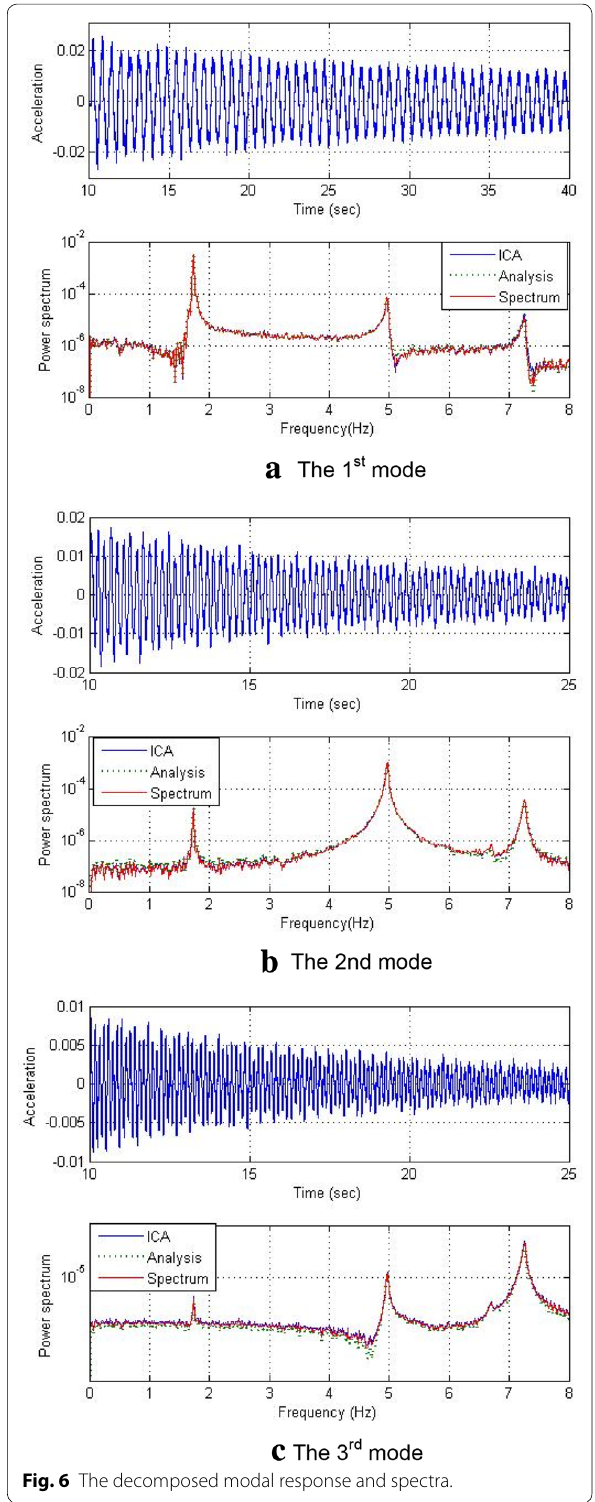
Fig. 6 The decomposed modal response and